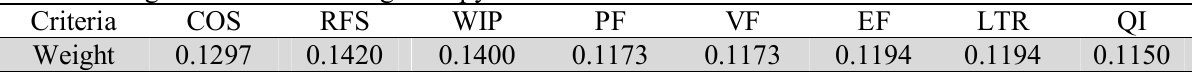
Criteria weights determined using entropy method Criteria